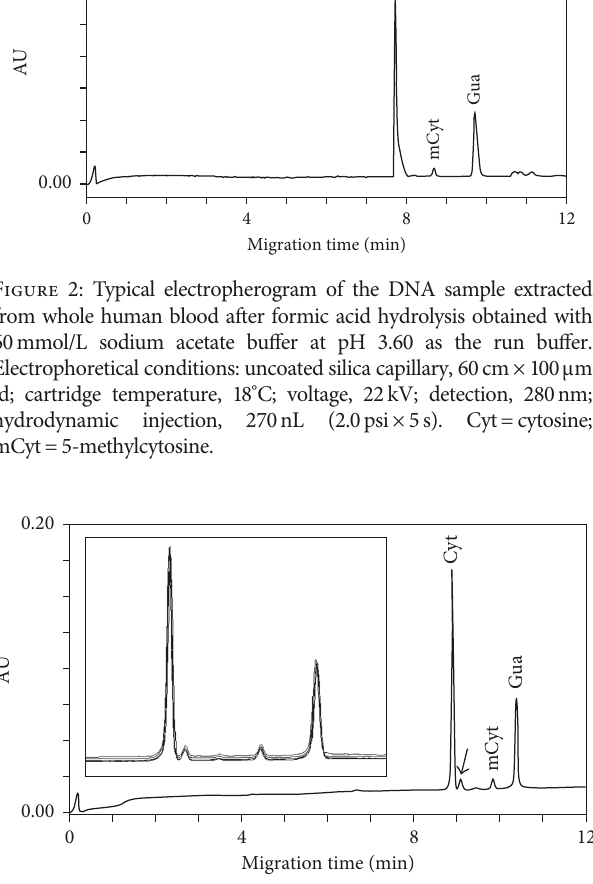
Figure 3: Typical electropherogram of the DNA sample extracted from whole human blood after formic acid hydrolysis obtained with 50mmol/L BTP phosphate buffer at pH 3.25 and 60mmol/L sodium acetate buffer at pH 3.60 (4 : 1, v/v ) as the run buffer. Electro- phoretical conditions: uncoated silica capillary, 60cm × 100 μ m id; cartridge temperature, 18 ° C; voltage, 22kV; detection, 280nm; hy- drodynamic injection, 270nL (2.0psi × 5s). Arrow indicates the contaminant peak. Panel shows five consecutive runs of hydrolysed DNA. Cyt (cid:136) cytosine; mCyt (cid:136) 5-methylcytosine; Gua (cid:136) guanosine. Peaks were identified by either co-injection with standards and through the analysis of absorbance